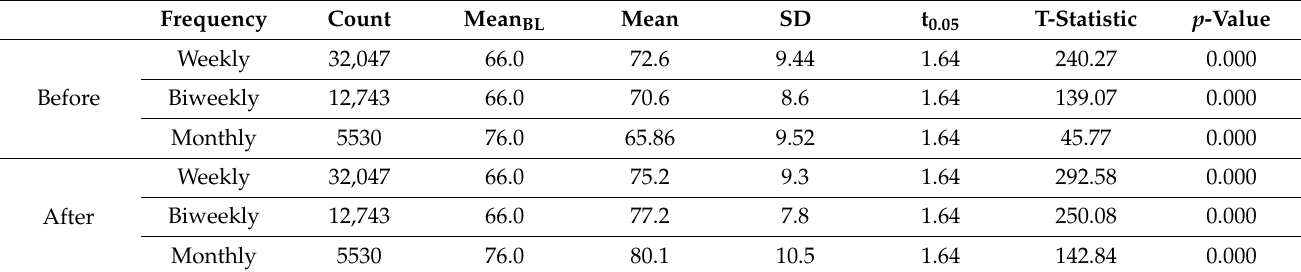
Table 6. One-tailed t -test of SR